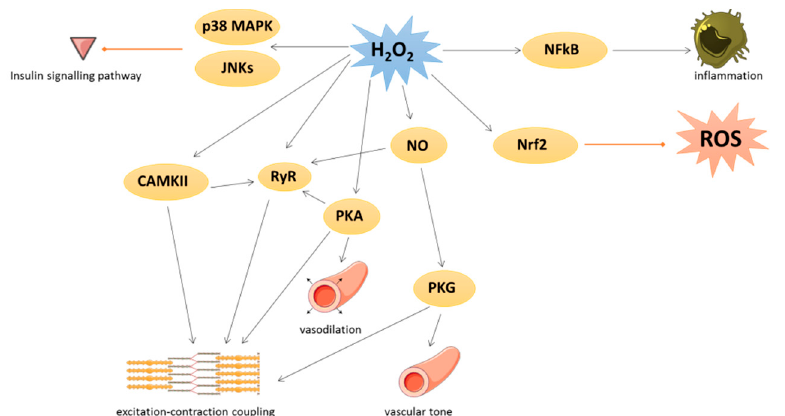
Figure 3. Physiological roles of oxidative stress in cardiovascular tissues. Black arrow represents activation and red arrow represents inhibition. p38 MAPK: p38 mitogen-activated protein kinase; JNK: c-Jun N-terminal kinase; H 2 O 2 : hydrogen peroxide; NF κ B: nuclear factor-kappa beta; CAMKII: Ca / calmodulin-dependent kinase II; RyR: ryanodine receptor; PKA: cAMP-induced protein kinase A; NO: nitric oxide; PKG: protein kinase G; Nrf2: nuclear factor erythroid 2-related factor